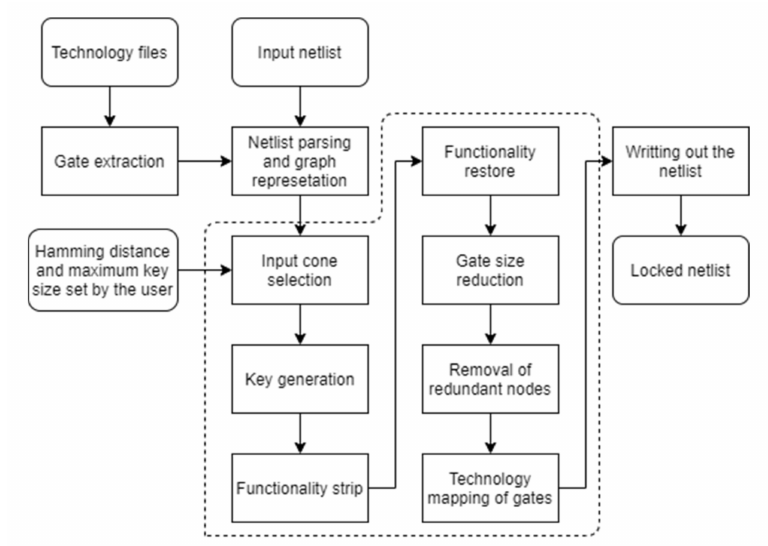
Figure 1. An algorithm flowchart.